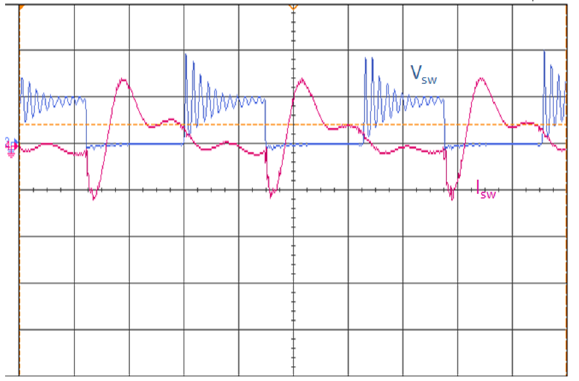
Figure 17. The turn on ZVS for the bridge.